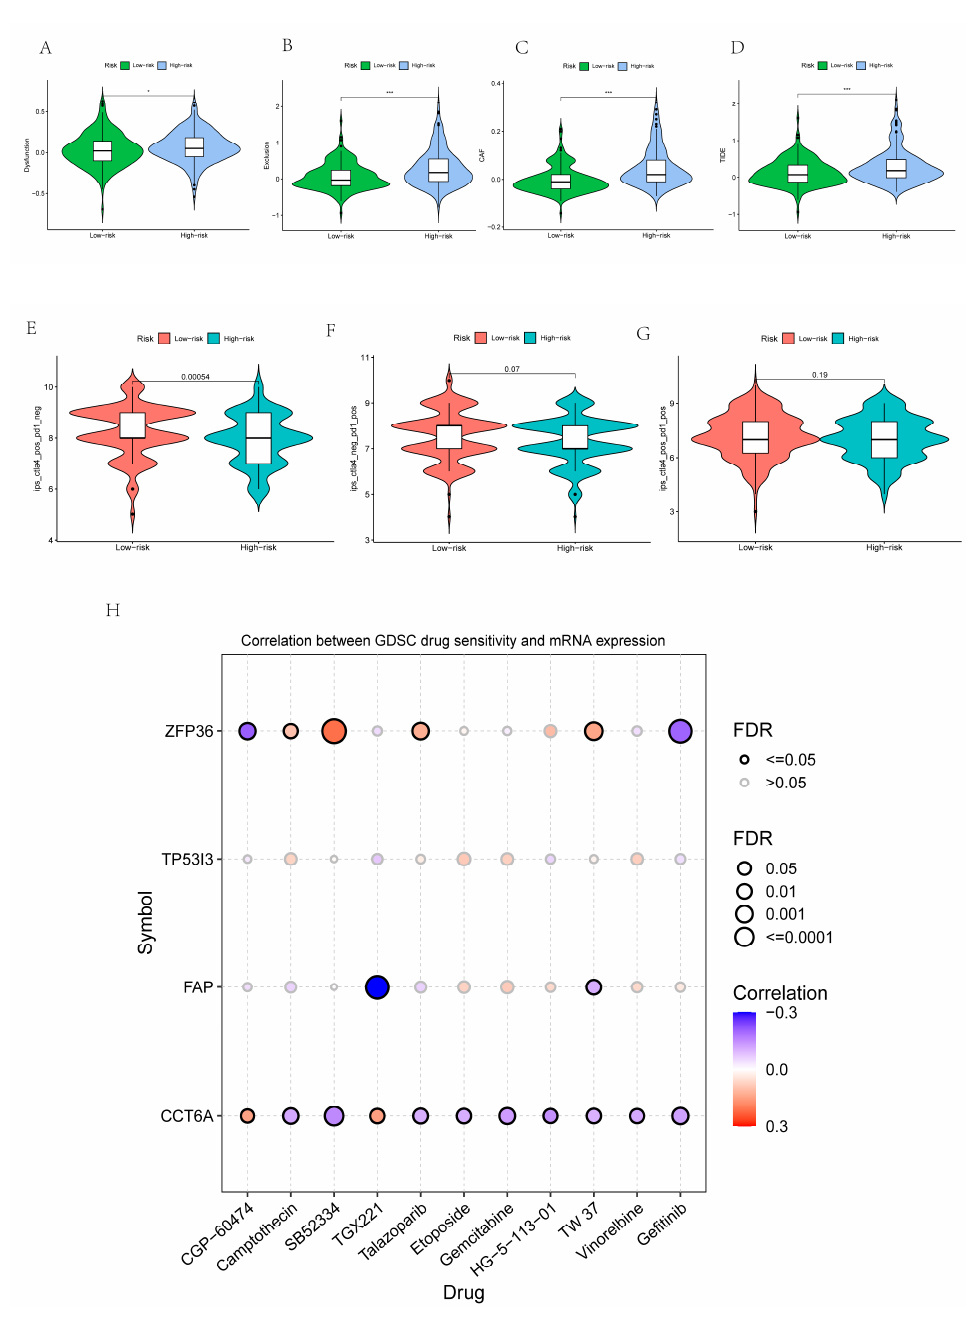
Figure 10. Identification of risk score and immunotherapy, ICIs and drug sensitivity and drug resistance of model genes. ( A – D ) analysis of Dysfunction, Exclusion, CAF and TIDE with risk score. ( E – G ) Anti-CTLA4 blockers, anti-pd1 blockers and the combination of anti-CTLA4 blockers with anti-pd1 blockers at different risks. ( H ) Analysis of drug sensitivity and drug resistance of four independent prognostic regulators related to necrotic apoptosis. (* p < 0.05, *** p <